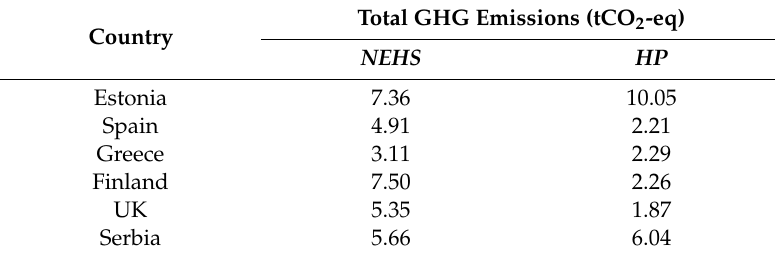
Table 8. Summary table for the total GHG emissions calculated per country and technology.